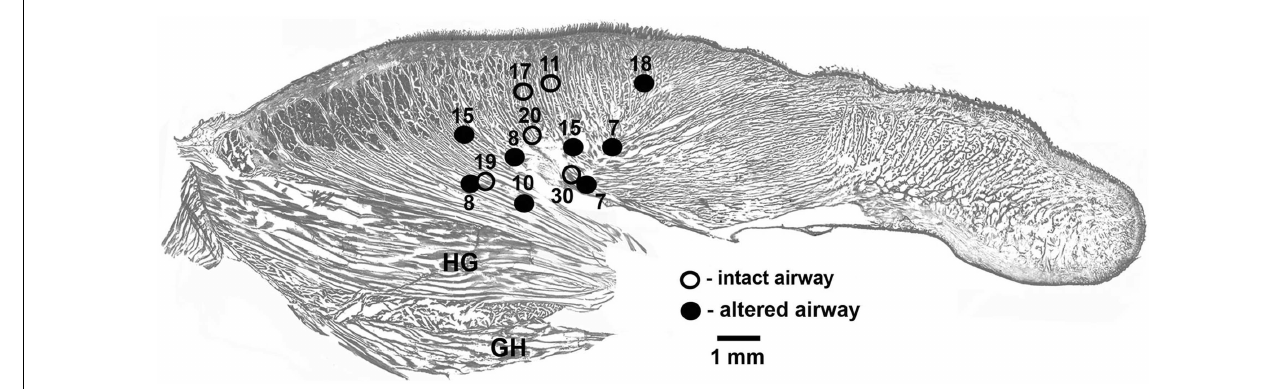
with intact upper airway (open circles) were analyzed.When signals from two sites in the same animal were available, the mean EMG levels recorded from the two sites were averaged to ensure that each animal contributed evenly to the group mean data.The numbers identify different